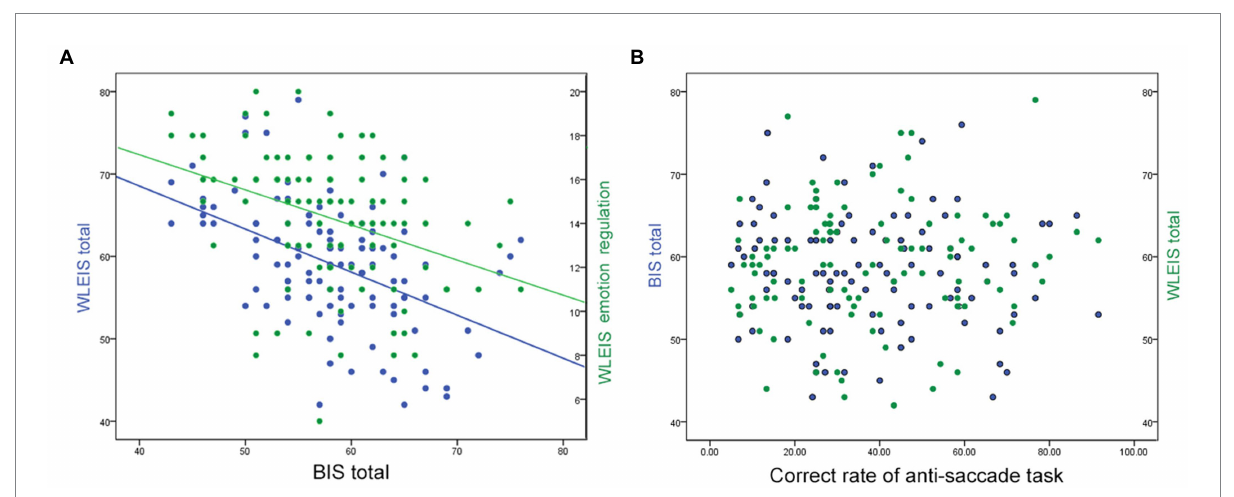
FIGURE 1 Correlations among BIS, WLEIS, and anti-saccade task. (A) , the correlation between BIS total and WLEIS total or emotion regulation scores; (B) , the correlation between the correct rate of anti-saccade task and BIS total or WLEIS total scores.